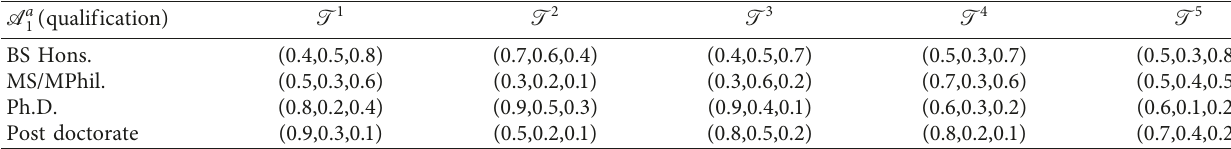
against qualification. i